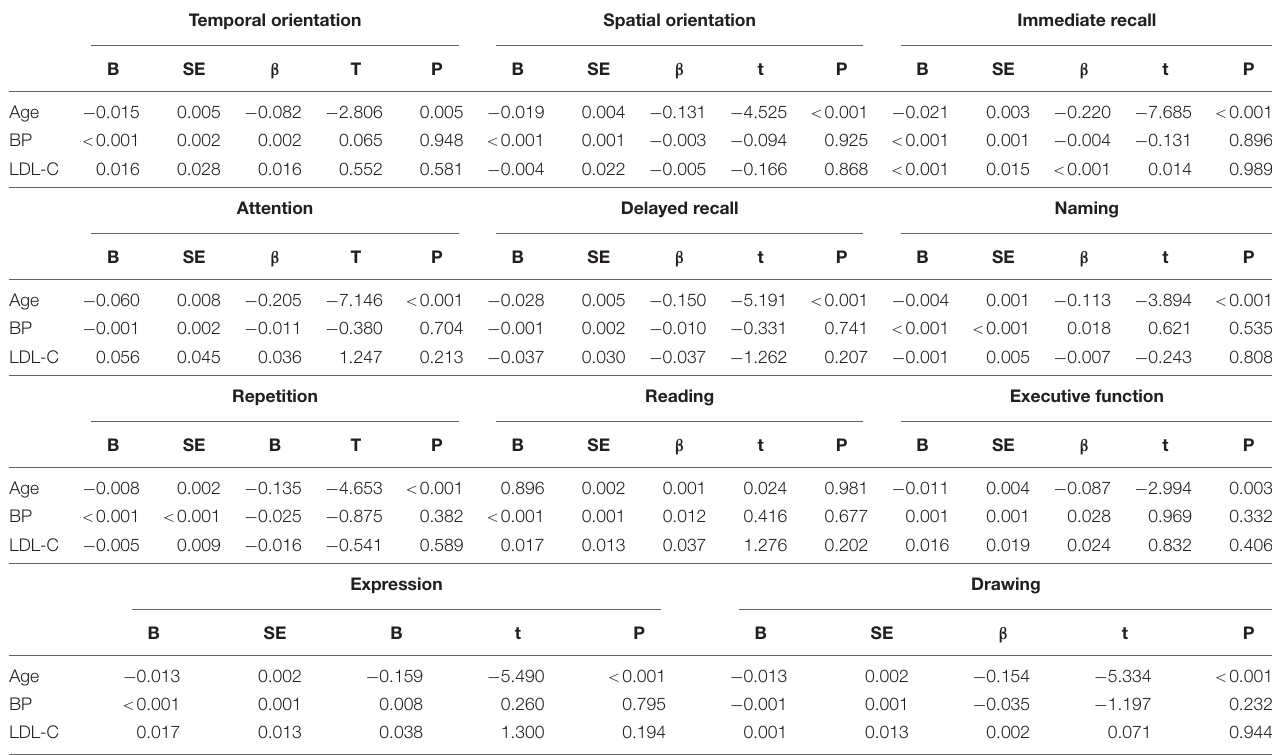
TABLE 4 | Multiple linear regression analysis of age, blood pressure and low-density lipoprotein cholesterol on 11 sub cognitive domains in Mini-mental State Examination, China, 2016. Temporal orientation Spatial orientation Immediate